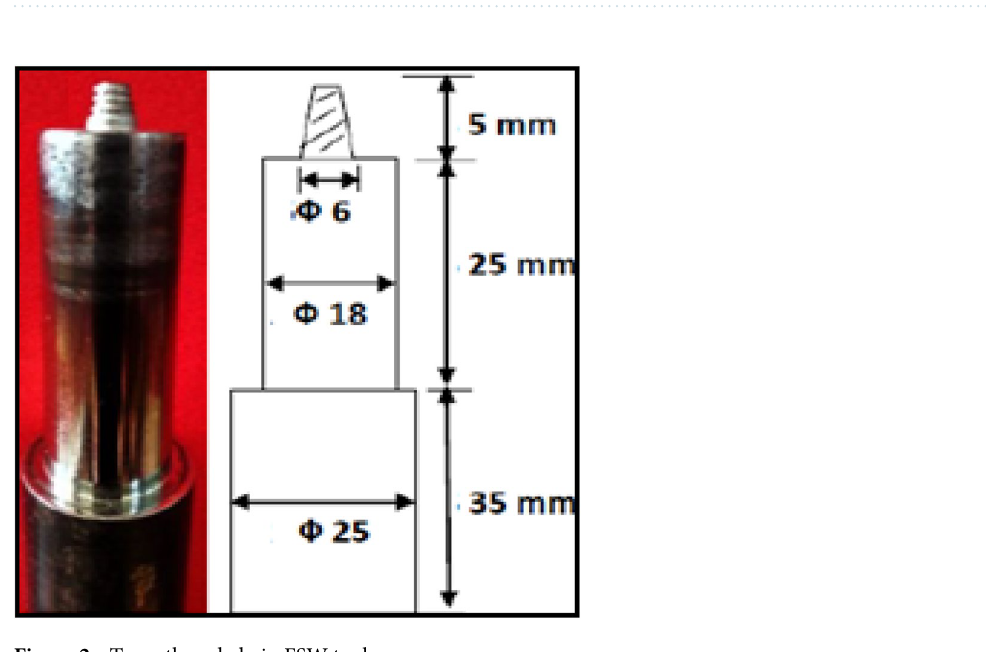
Figure 2. Taper threaded pin FSW